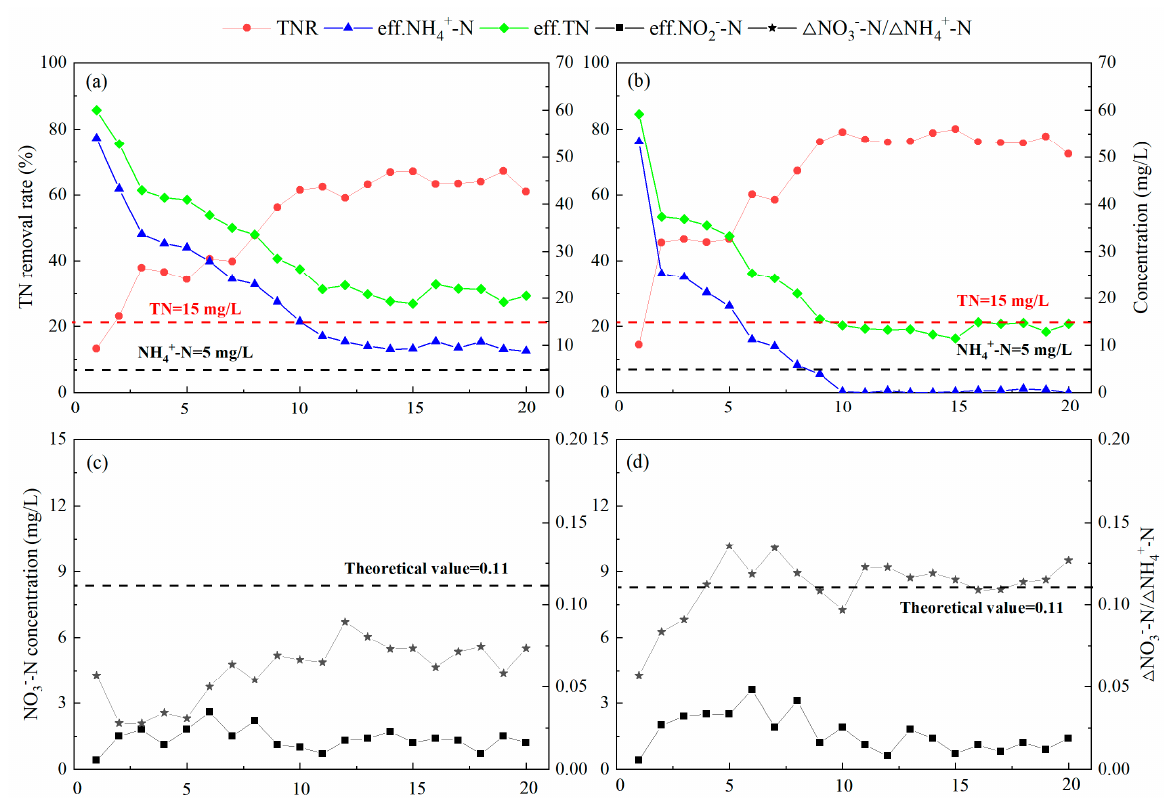
Figure 2. The nitrogen removal performance of the A1 ( a , c ) and A2 ( b , d ) immobilized filler reactors.